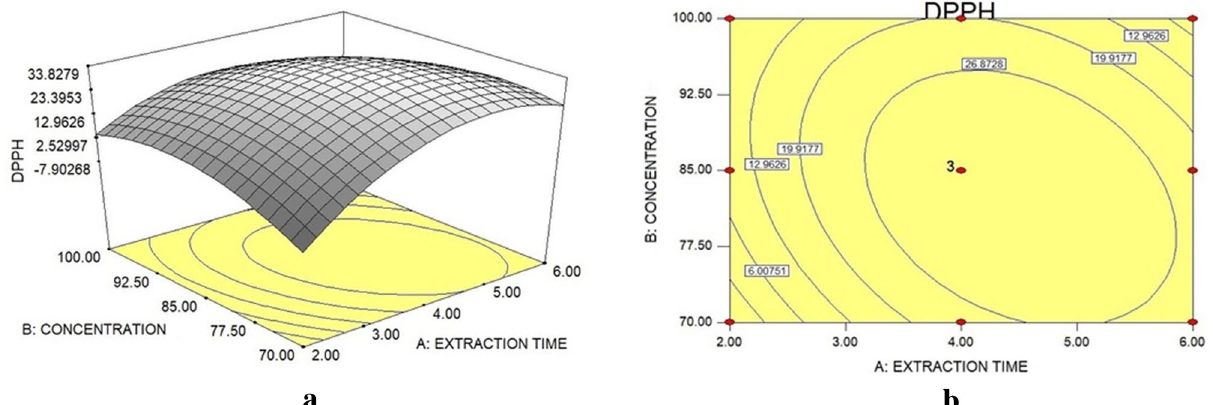
Figure 3. Response surface ( a ) and contour lines ( b ) of the DPPH statistical analysis of the aqueous extract obtained via Soxhlet for extraction